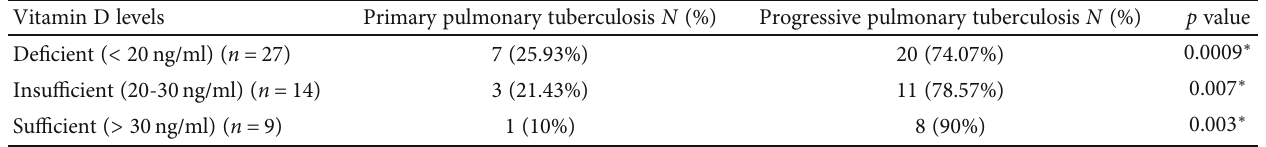
Table 3: Vitamin D level in primary pulmonary tuberculosis and progressive pulmonary tuberculosis.